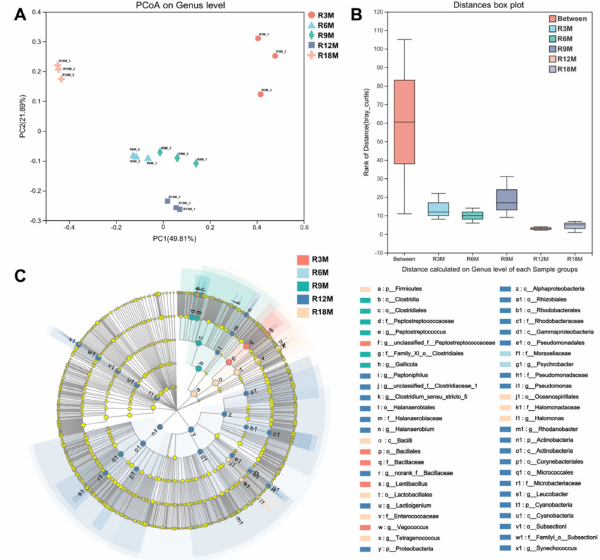
Figure 3. The influence of fermentation time on the microbial composition in fish sauce. ( A ) PCoA (Bray–Curtis). Different samples are represented by points of different colors or shapes. The closer the points are, the more similar the species composition of the samples. ( B ) ANOSIM. The “Be- tween” boxes refer to differences between groups, the others represent differences within each group. ( C ) LEfSe. Microorganisms that are significantly enriched in the corresponding group are represented by nodes with different colors and have a significant impact on the differences between groups. (R3M, R6M, R9M, R12M, R18M indicated for 3, 6, 9, 12, 18 months,